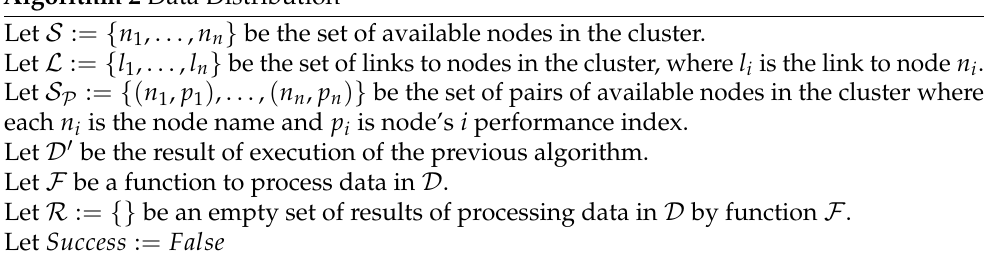
Algorithm 2 Data